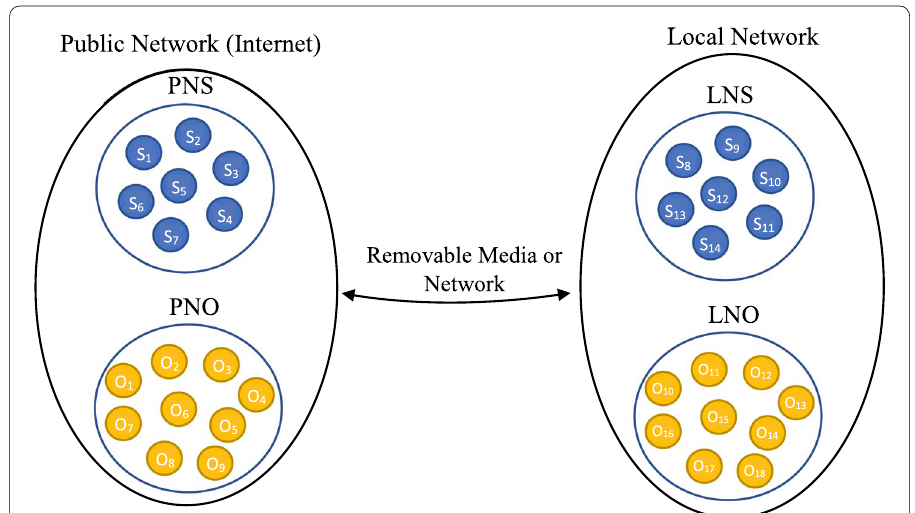
Fig. 6 Data exfiltration from local network to the public network